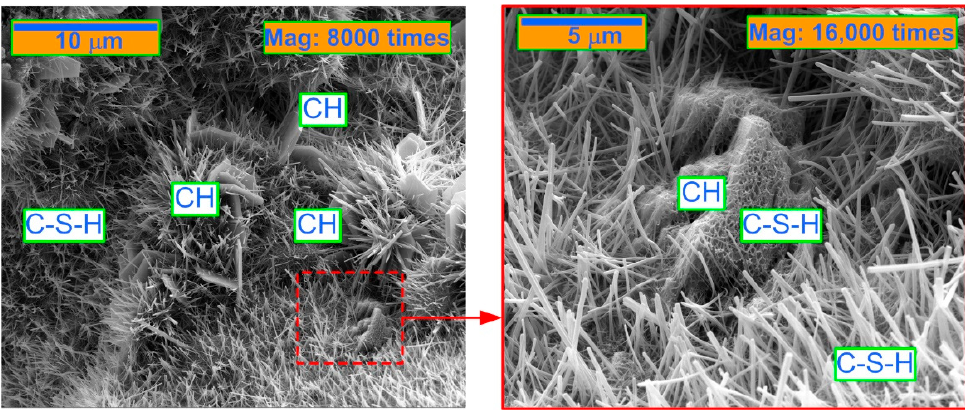
analyzed concretes.